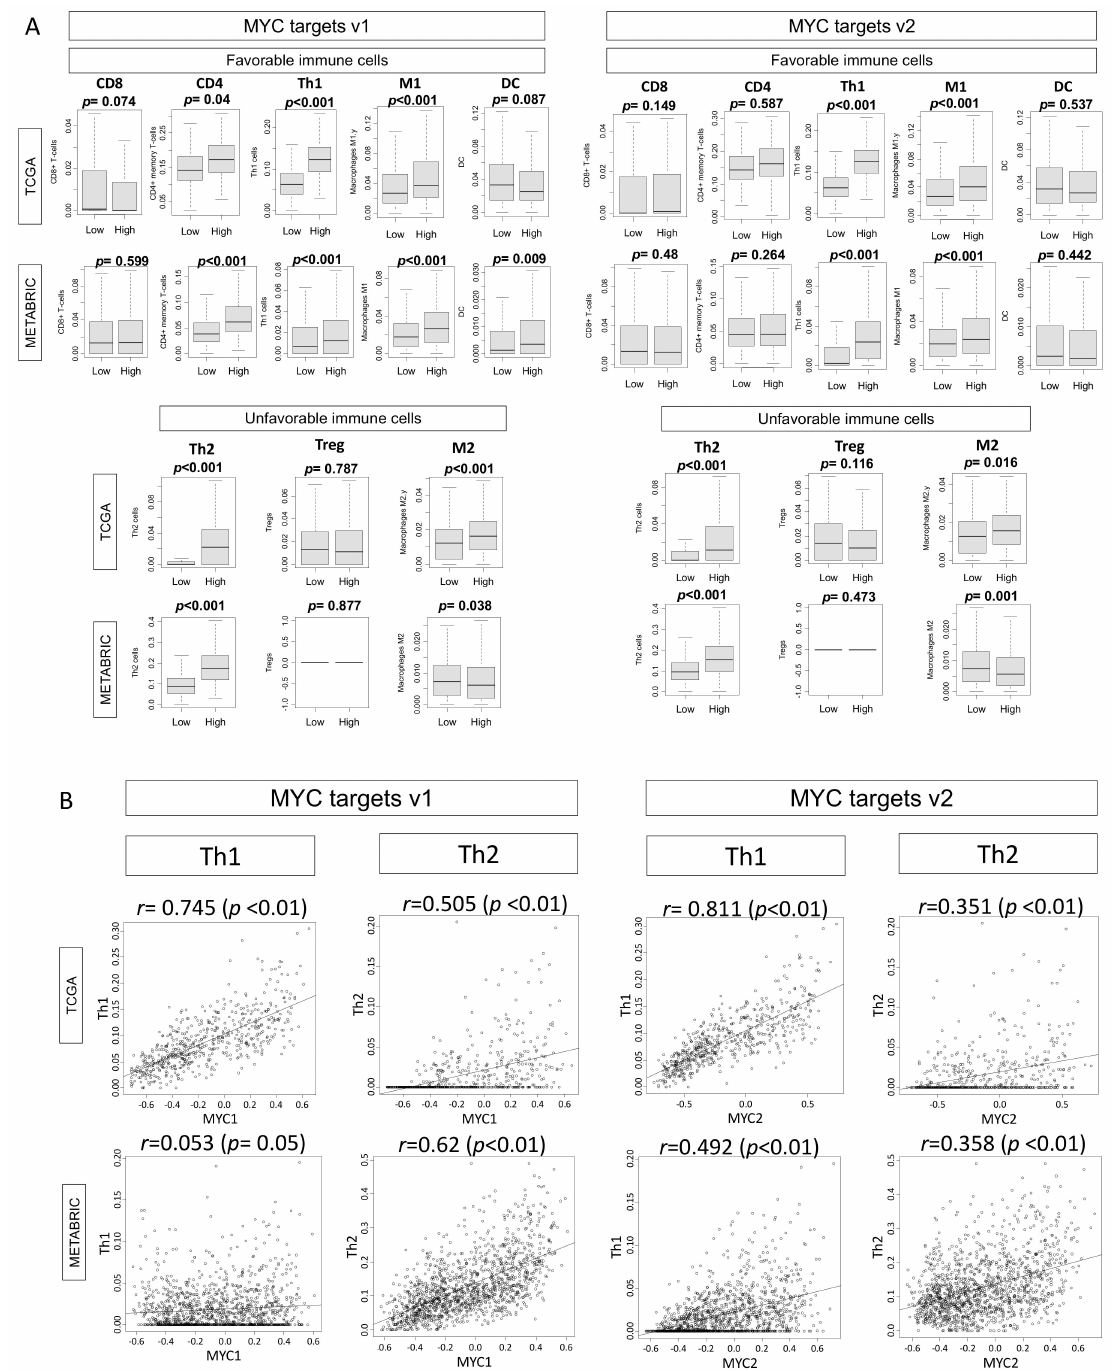
Figure 5. Association of the MYC targets v1 and v2 scores with fraction of tumor infiltrating immune cells in ER-positive / HER2-negative breast cancer. ( A ) Boxplots of high and low MYC v1 and v2 scores and infiltration of immune cells. Favorable immune cells: CD8, CD4, T helper type I (Th1) cells, M1 macrophages, dendritic cells (DC); unfavorable immune cells; T helper type 2 (Th2) cells, regulatory T (Treg) cells, M2 macrophages in ER-positive / HER2-negative breast cancer in TCGA and METABRIC cohorts. ( B ) Correlation of the MYC targets v1 and v2 scores with fraction of Th1 and Th2 cells in ER-positive / HER2-negative breast cancer in the TCGA and METABRIC